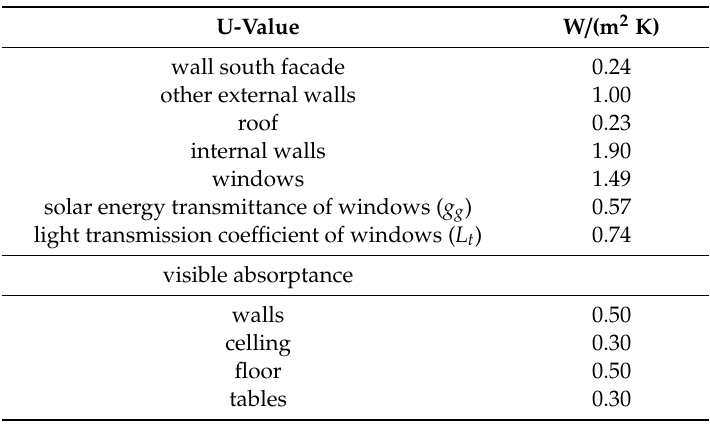
Table 1. Characteristic parameters of building envelope. 100